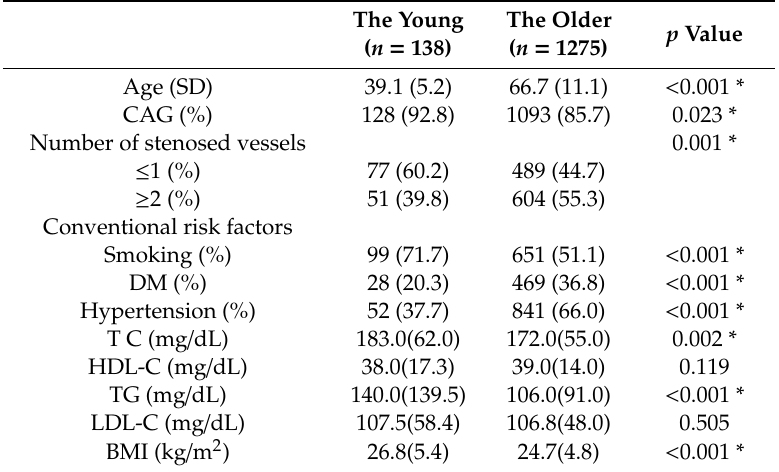
Table 1. Comparison of clinical characteristics between the young group and the older group.